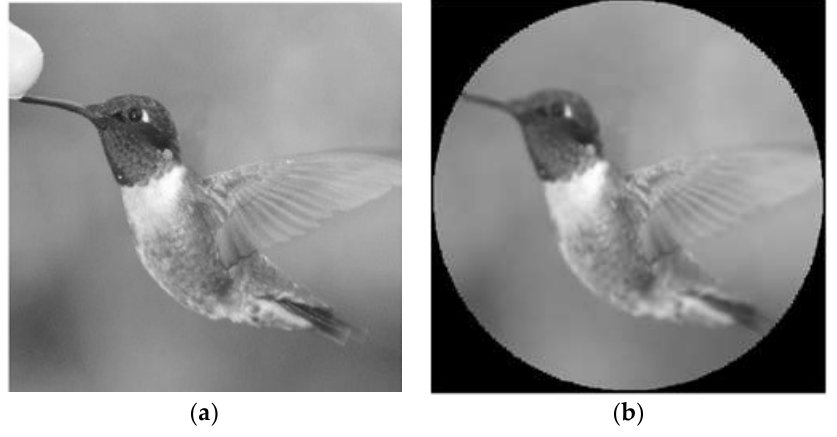
Figure 9. Example of foveated image. ( a ) Input (full-resolution) image; ( b ) Foveated image using log-polar receptive field layout.